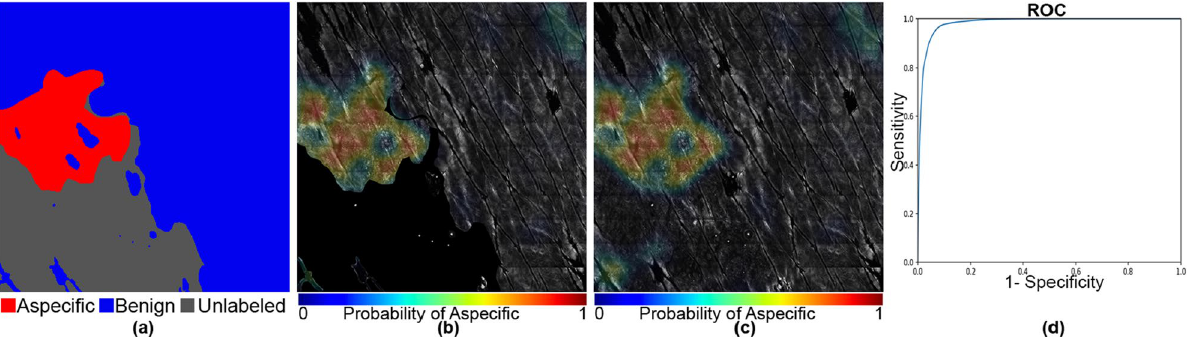
Figure 5. An example of both aspecific, unlabeled, and benign patterns with an AUC of 0.982 and a Dice coefficient of 0.83. The mask and the heat map images are generated using OpenCV 4.5.1.48 (https ://pypi.org/ proje ct/openc v-pytho n/) library in Python 3.7.4 (https ://www.pytho n.org/downl oads/relea se/pytho n-374/). The images and the legends are put together using Photoshop CC 2018.